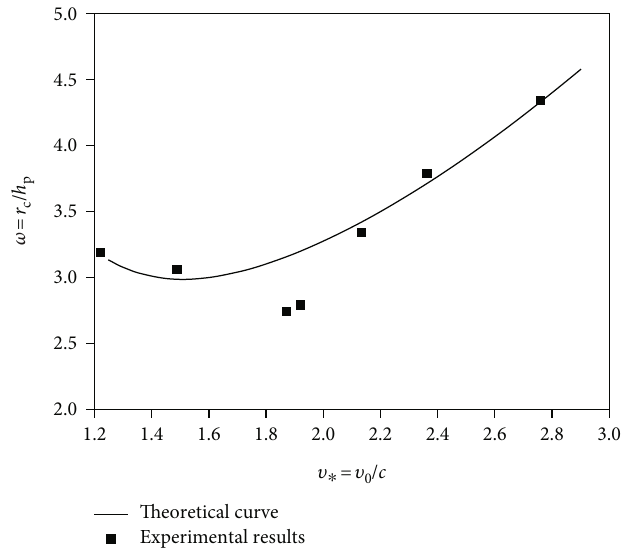
Figure 5: Experimental and theoretical parameter ω vs. scale velocity υ